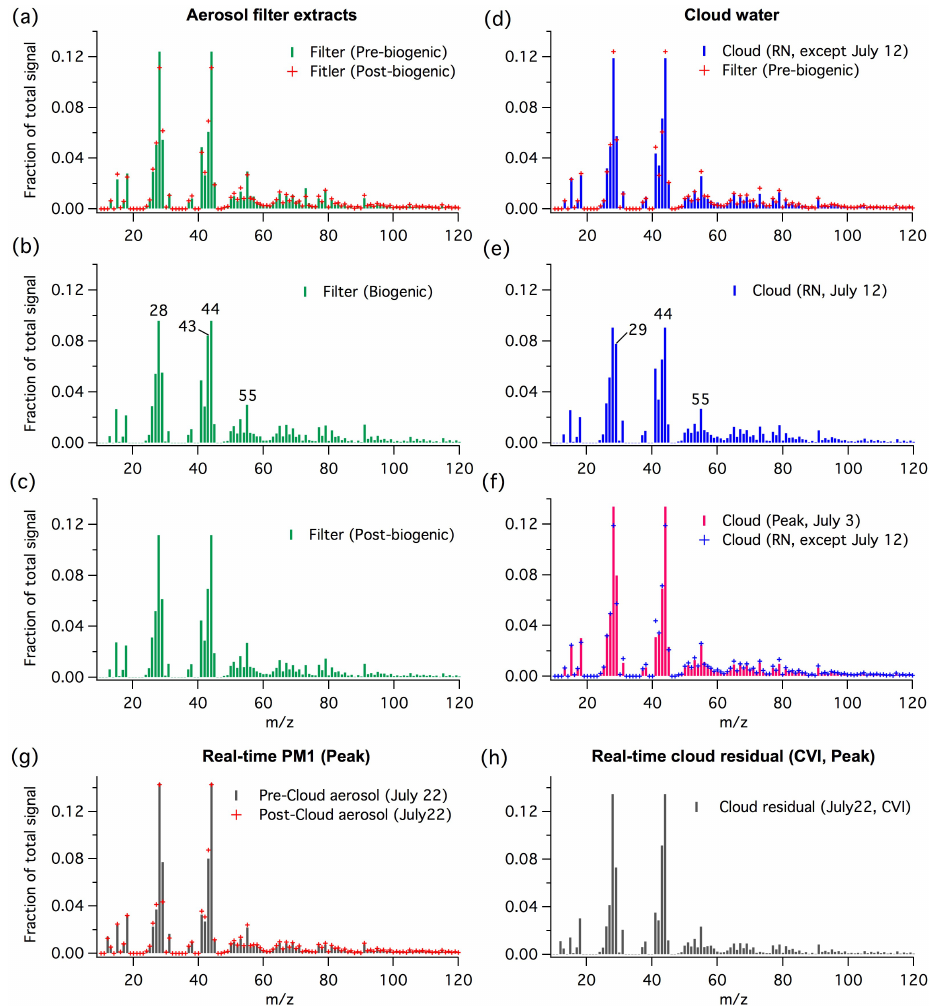
Fig. 2. Average AMS organic spectra (normalized by AMS organic mass) of aerosol filter extracts (a–c) , cloud water (d–f) , real-time PM1 in pre- and post-cloud period (g) and real-time cloud residuals at the peak sites (h) . The cloud water collected on 12 July at RN has much higher intensity at m/z 29 compared to all other cloud water samples and thus it is not included in the average organic spectrum of cloud water (d) .